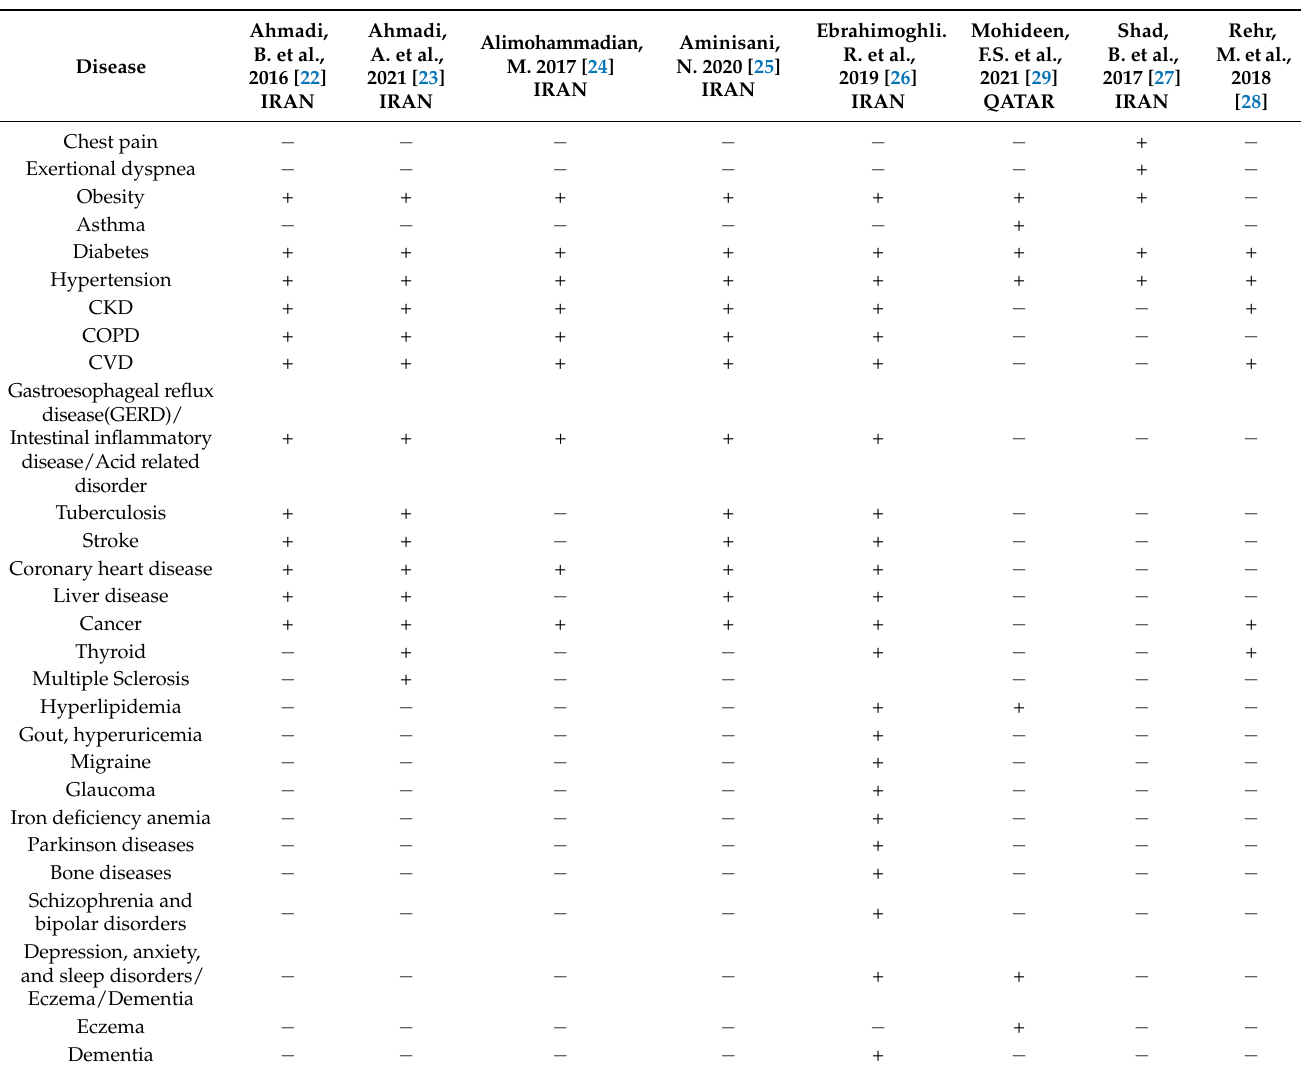
Figure 2. Multimorbidity prevalence in Middle East countries [22–29]. Table 2. Diseases reported in studies.